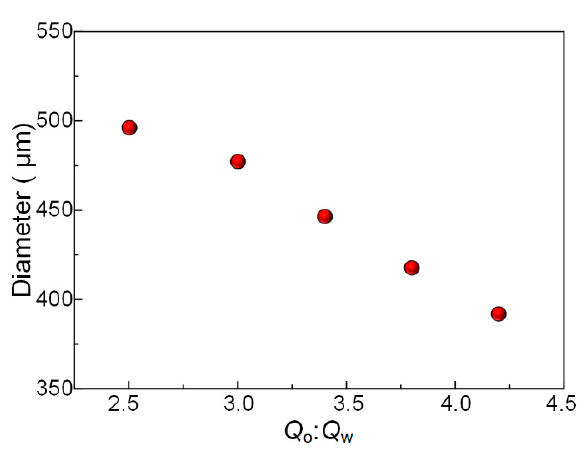
Figure 3. Control of the size of microspheres.